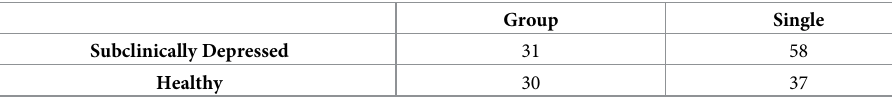
Table 3. Number of observations in the subclinical sample by